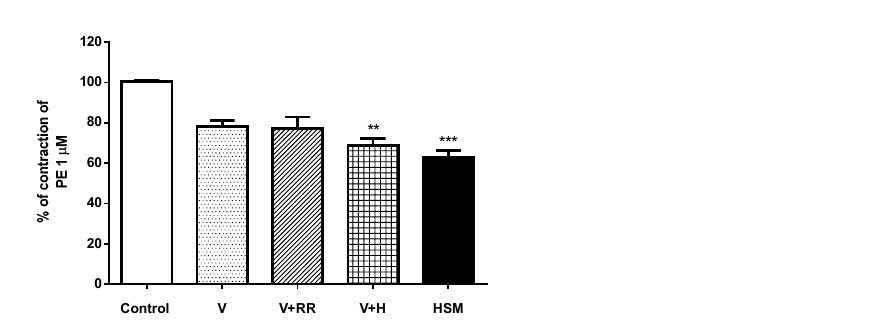
Figure 6. The effects of preincubation with verapamil (V, 1 µ M), the combinations of V with ruthenium red (10 µ M) (V + RR) or V with heparin (50 mg/mL) (V + H), and H. stoechas extract (HSM, 3 mg/mL) on contraction to PE (1 µ M) in rat aorta. The Kruskal-Wallis test was performed. Data points are mean ± SEM ( n = 6–8). ** p < 0.01 and *** p < 0.001 vs. control (response alone to PE).